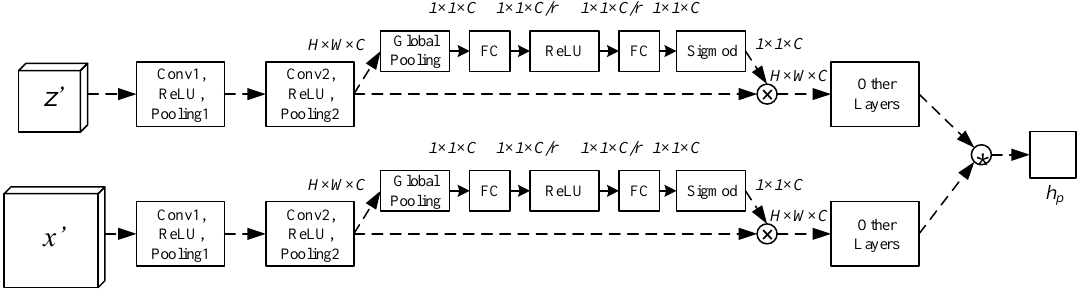
Figure 6. The structure of Siamese neural network with SE attention module.